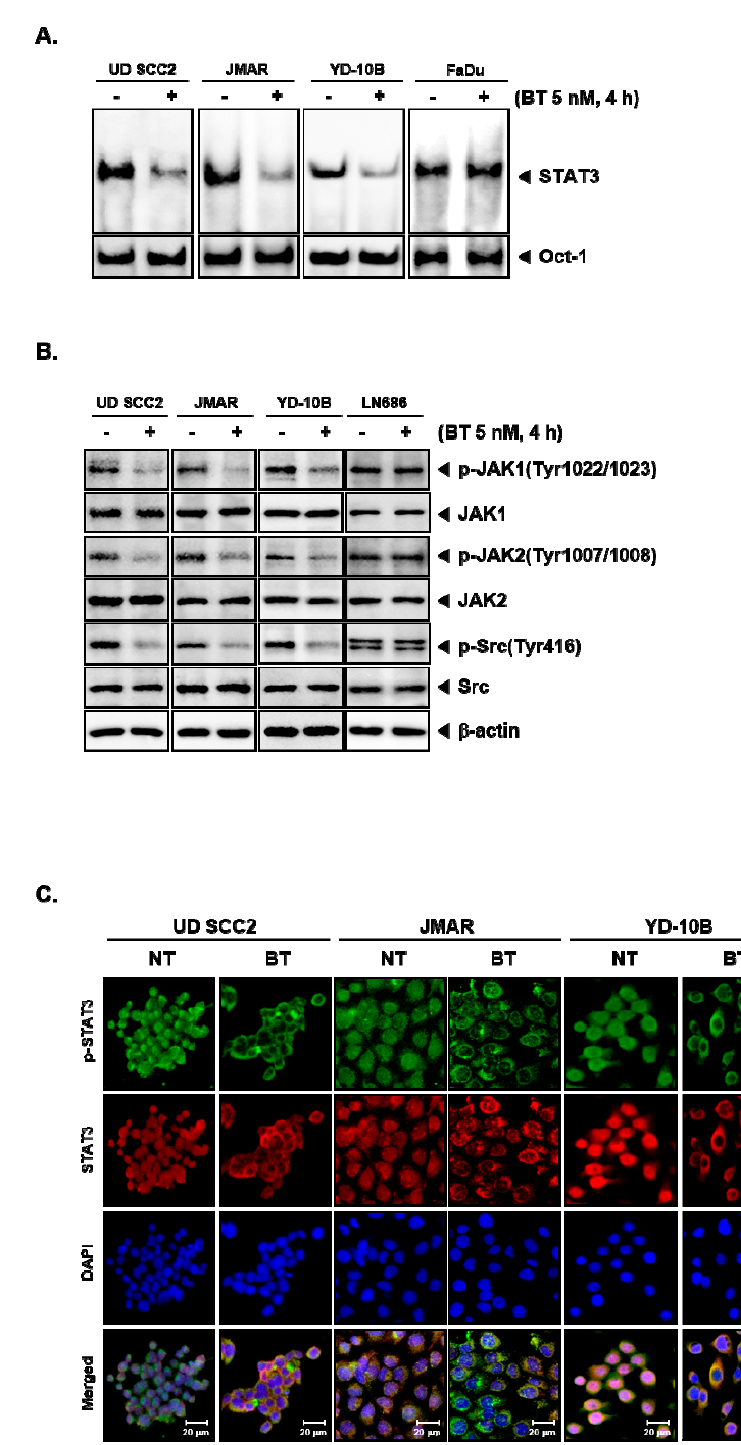
Figure 2. BT downregulates upstream signaling pathway of STAT3. ( A ) Nuclear extracts from non-treated (NT) HNSCC (UD SCC2, JMAR, YD-10B, and FaDu) or treated with 5 nM of BT for 4 h were tested for DNA binding to STAT3 by electrophoretic mobility shift assay (EMSA). Oct-1 was used as a loading control. ( B ) HNSCC cells (UD SCC2, JMAR, YD-10B, and LN686) were treated with 5 nM of BT for 4 h. And western blotting was done as indicated above. β -actin was used as an input control to verify equal protein loading. ( C ) HNSCC (UD SCC2, JMAR, YD-10B) cells were either non-treated (NT) as control or treated with 5 nM of BT. And analyzed for the intracellular distribution of p-STAT3 and STAT3 by immunocytochemistry. The nuclei are counterstained with DAPI (5 μ g/mL) for 3 min.